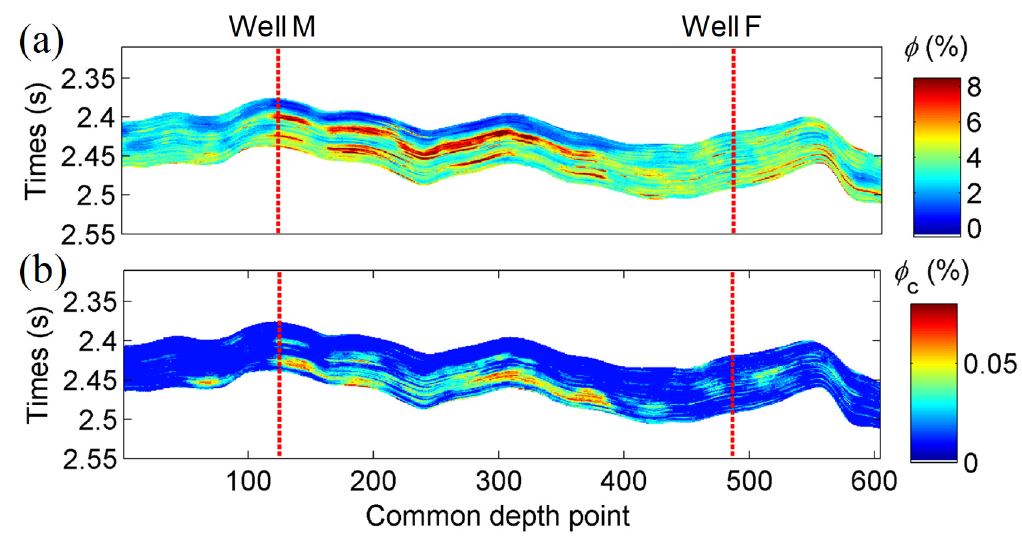
Figure 16. Inversion results of total ( a ) and microcrack ( b ) porosities corresponding to the data of Figure 15.